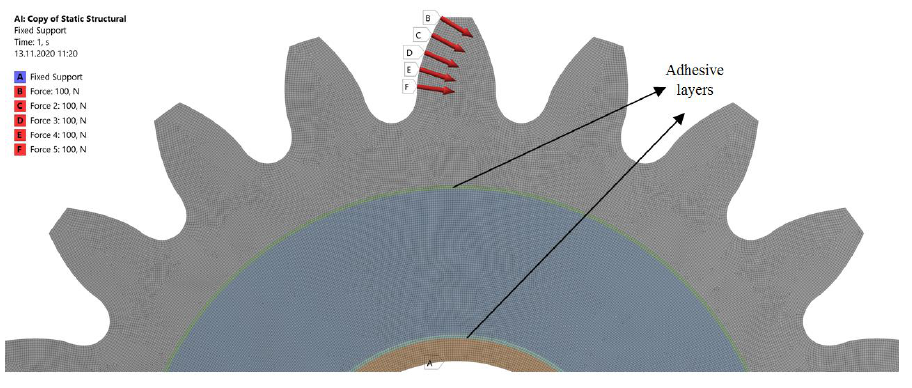
Figure 3. The load and support conditions.